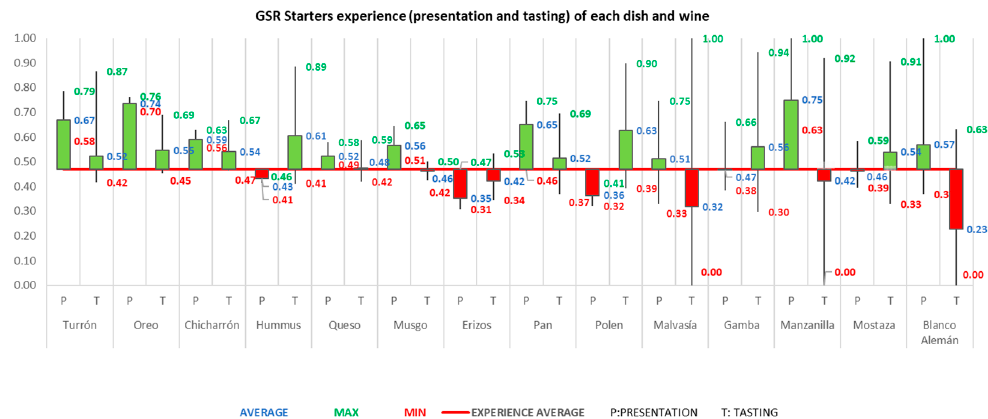
Figure 3. Galvanic skin response analysis for each dish and wine (presentation and tasting): Starters group. Source: Original work from the authors.